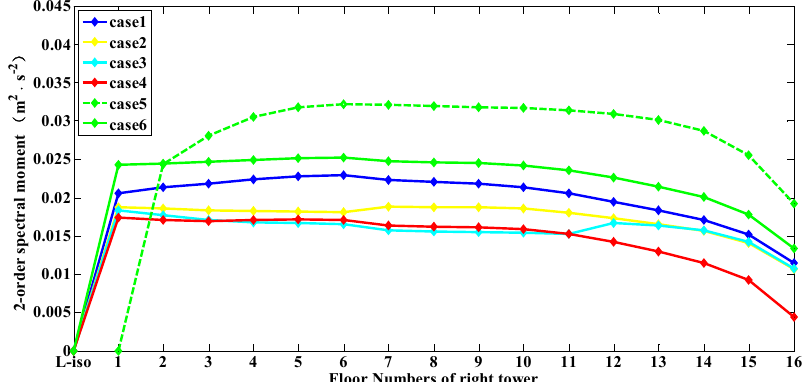
Figure 14. Second-order spectral moment of the displacement of each layer of the right tower.